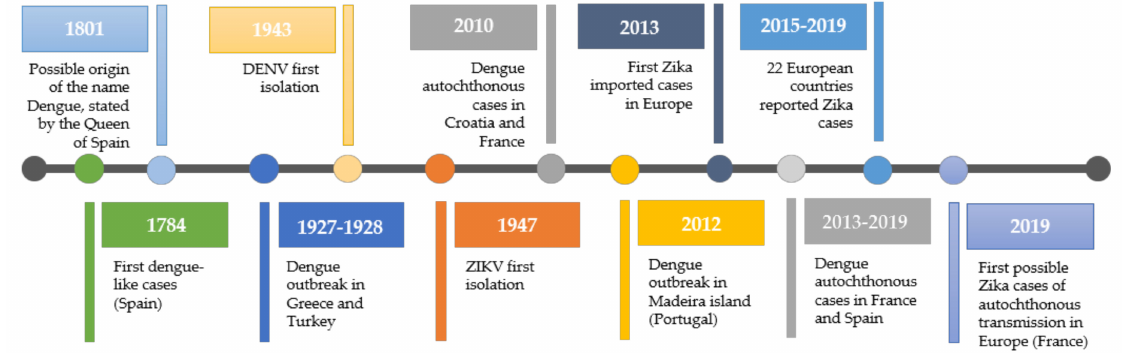
Figure 1. Timeline of dengue and Zika cases in Europe. Dengue has been present in Europe and is considered an emerging threat by the European Center for Disease Control and by the European Union (EU) public health authorities. The mosquito is found in the region, leading to recent outbreaks. Thus, it must be accounted for in terms of public health policies across the EU. Table 1. Number of reported and travel-associated cases of dengue and Zika in Europe [44]. Dengue Zika Year Reported Cases Travel-Associated Cases Reported Cases Travel-Associated